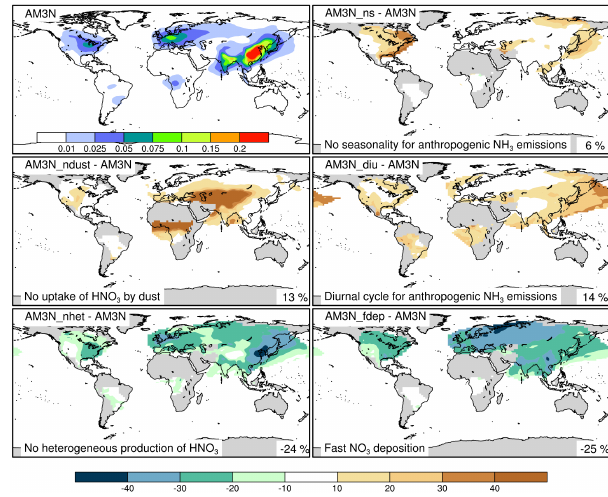
Figure 9. Contribution of different aerosol types to the global mean annual aerosol optical depth at 550nm in AM3, AM3N, and other climate models considering NO − aerosol (all-sky except clear- 3 sky for GISS). AM3 and AM3N AOD are representative of 2010 conditions, while other models reflect 2000 conditions. The range of SO 2 − , NO − , and total AOD across AM3N configurations are 4 3 shown by red, light blue, and black horizontal bars respectively. Note that changes in the parameterization of NH 3 convective re- moval reduce the simulated NO − optical depth by GISS to 0.005 3 (S. Bauer, personal communication, 2015).